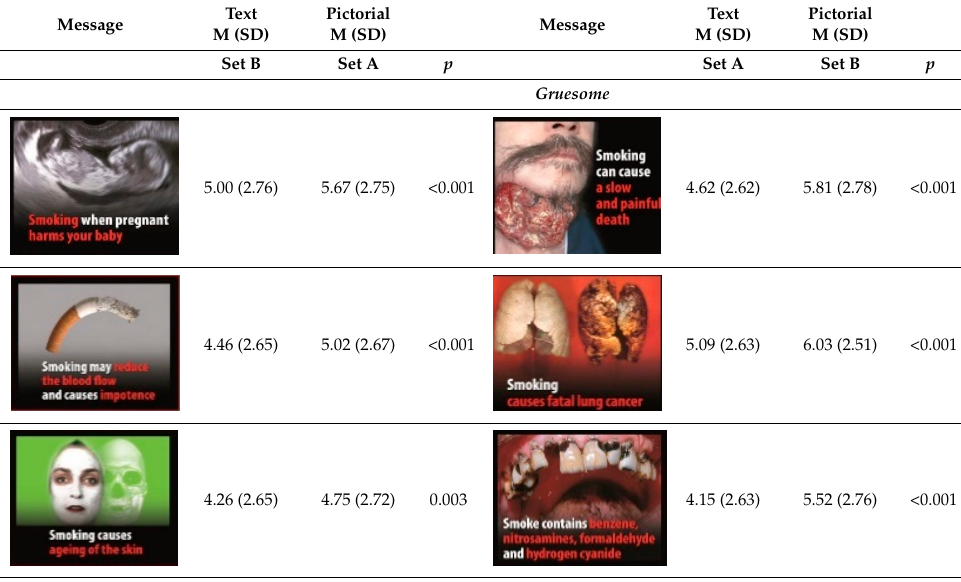
Table 1. Comparison of persuasiveness of graphic versus text-based messages.